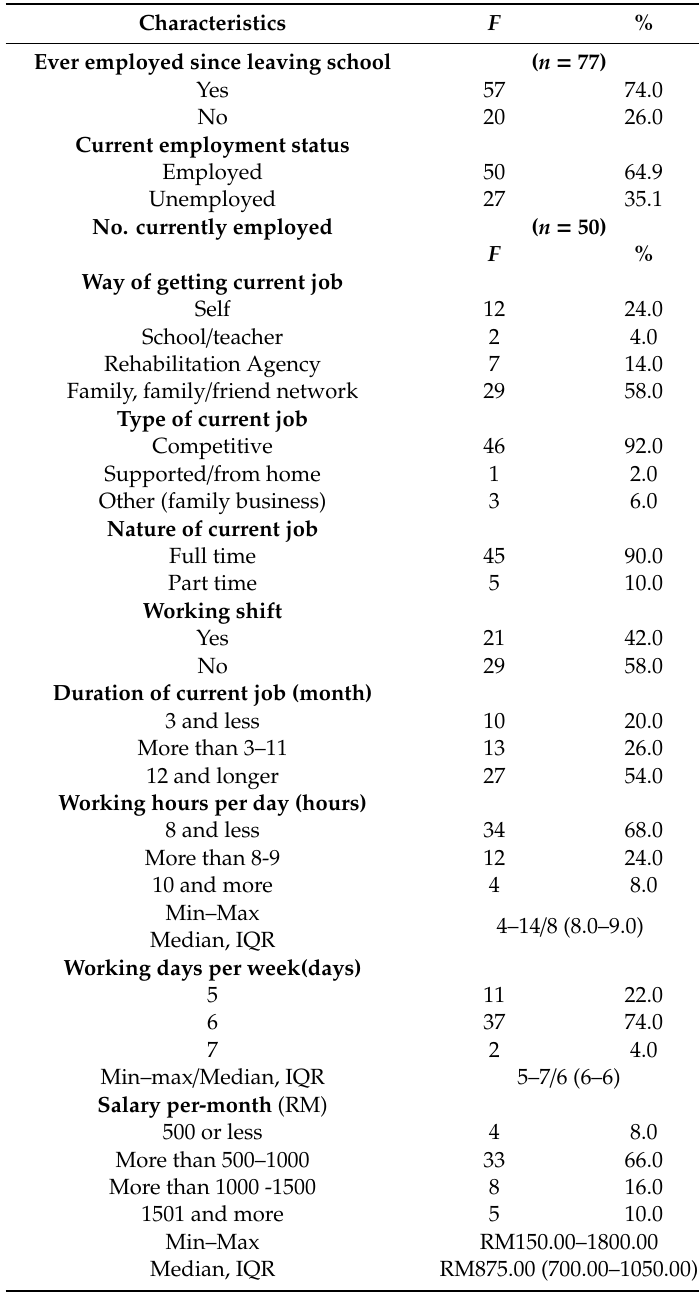
Table 2. Characteristics of respondents ( n =